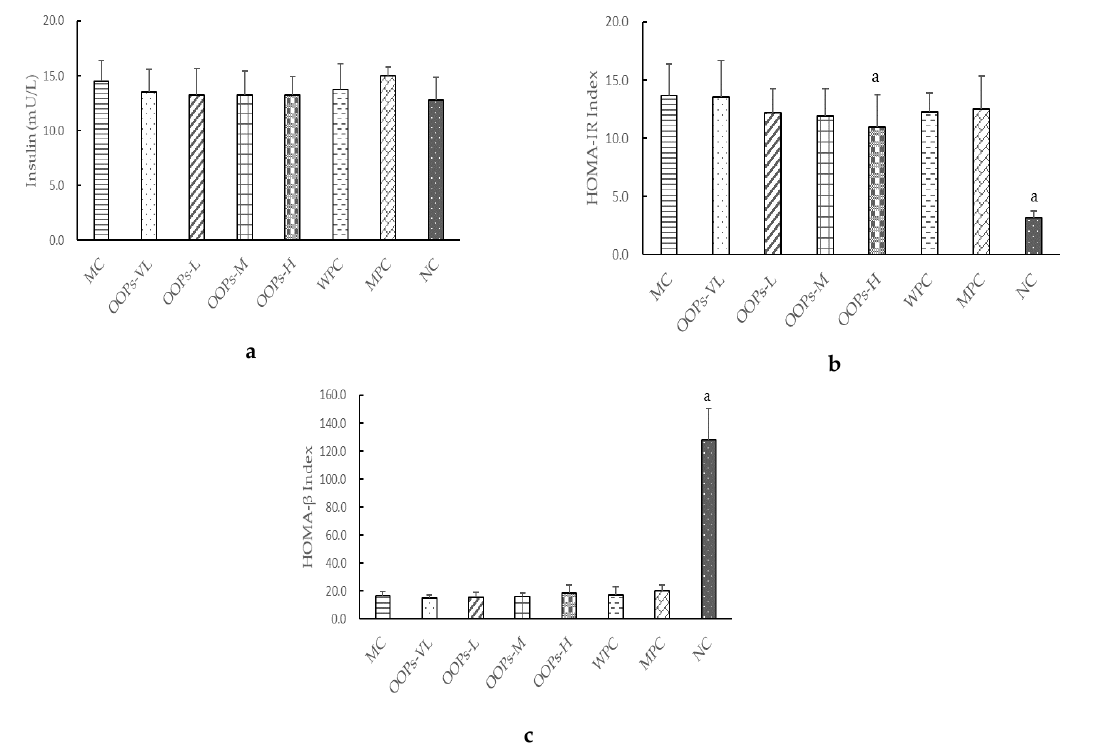
Figure 3. Effect of OOPs treatment on the fasting insulin ( a ), HOMA-IR-Index ( b ), and HOMA- β Index ( c ). Values are expressed as the means ± SD of 8 rats in each group. a p < 0.05 versus MC group. 125